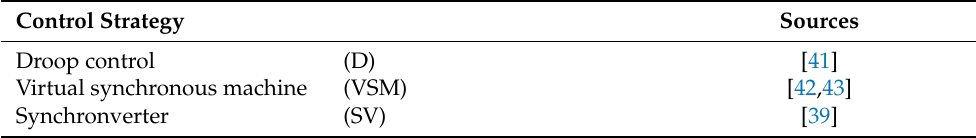
Table 1. GFM control strategies considered in this study. Control Strategy Sources Droop control (D) [41] Virtual synchronous machine (VSM) [42,43]